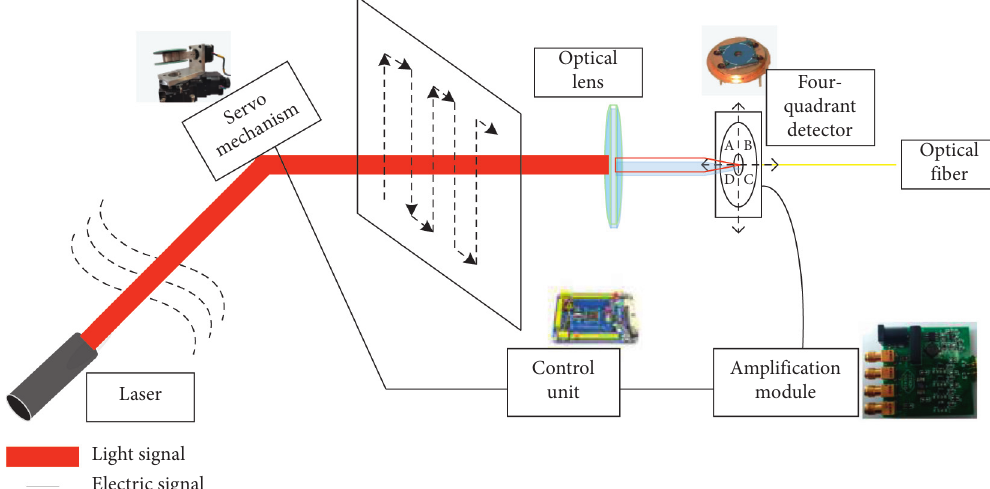
Figure 1: Schematic diagram of airborne laser communication automatic tracking control